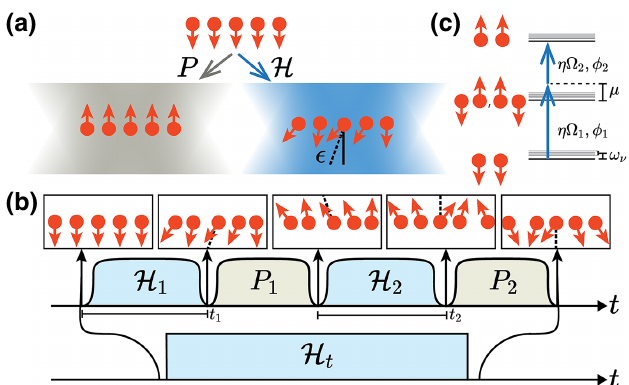
FIG. 1. A schematic of the dynamical decoupling scheme for quantum simulations. (a) We consider a spin system that can be subjected to two classes of controllable operations (illustrated as driven by a pair of laser beams): overall global rotation pulses ( P n ) and Hamiltonian evolution for some period of time ( H n ). The Hamiltonian evolution induces interactions (represented by fluctuating spin angles) but can also introduce a coherent error (represented by a tilt of (cid:2) in the average spin axis). (b) The goal of the dynamical decoupling sequence is to alternate periods of H n and P n operations, so that the final evolution after the pulse sequence corresponds to evolution (up to an overall rescaling) under a target Hamiltonian H t while the error (cid:2) is canceled out. (c) The level schematic for spin-spin interactions generated by the Mølmer-Sørensen technique described in Sec. III. For sim- plicity, the two-ion case is shown and only transitions from the absolute ground state are